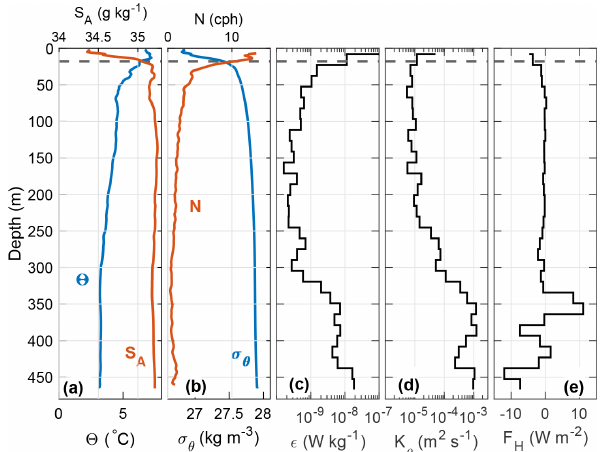
Figure 8. Same as Fig. 7, but for station R4, Section C. Lower limit of the stream tube is the seabed at